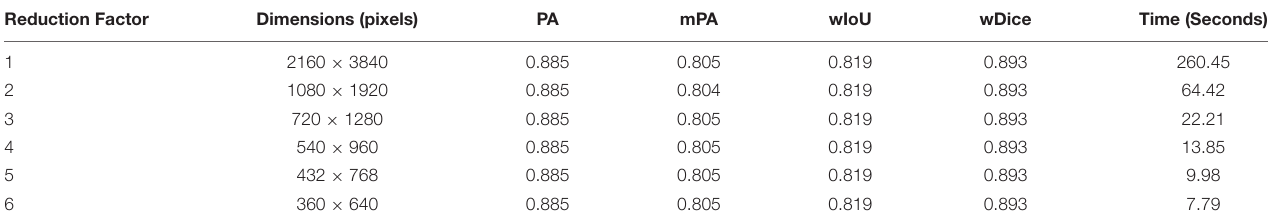
TABLE 1 | The effect of reducing an input image’s dimensions on the output of Fast-MSS. Reduction Factor Dimensions